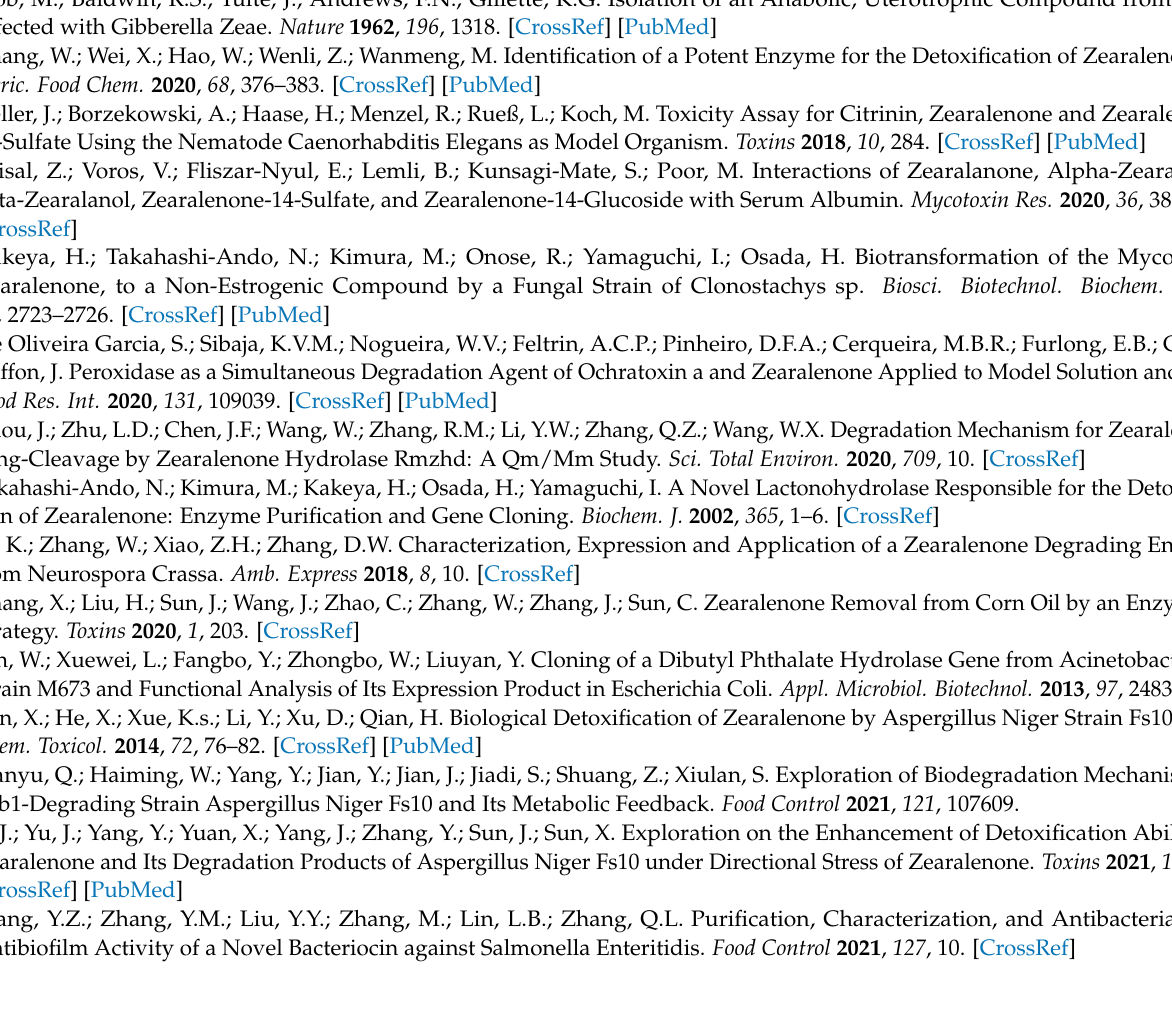
SWISS-Model; Table S1: 18s rDNA sequencing of ZEN-S-FS10; Table S2: Sequencing and splicing results of ZEN-S-FS10; Table S3: Amino acid sequencing results of FSZ; Table S4: The protein sequence of FSZ; Table S5: